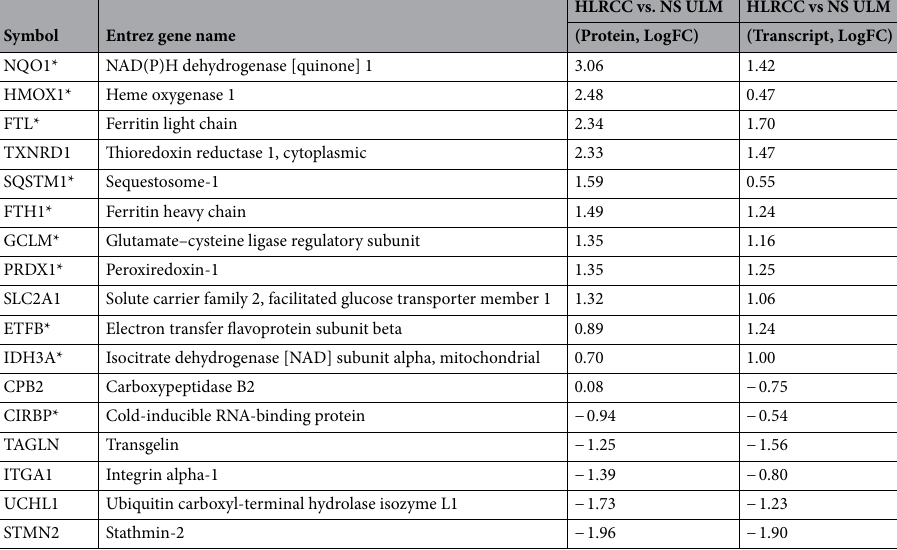
Diseases or Biofunctions Activation z-score Cell proliferation of tumor cell